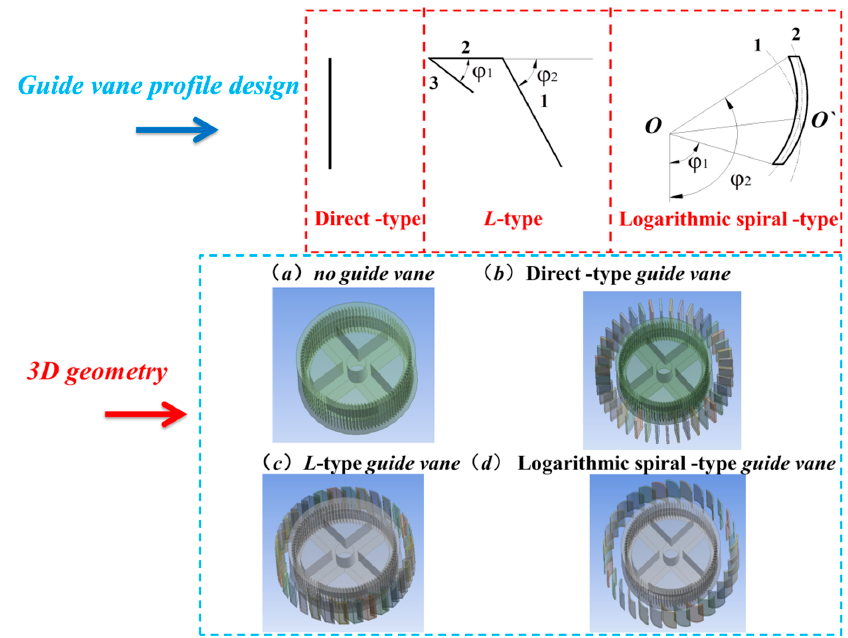
Figure 6. Different types of guide vanes design.